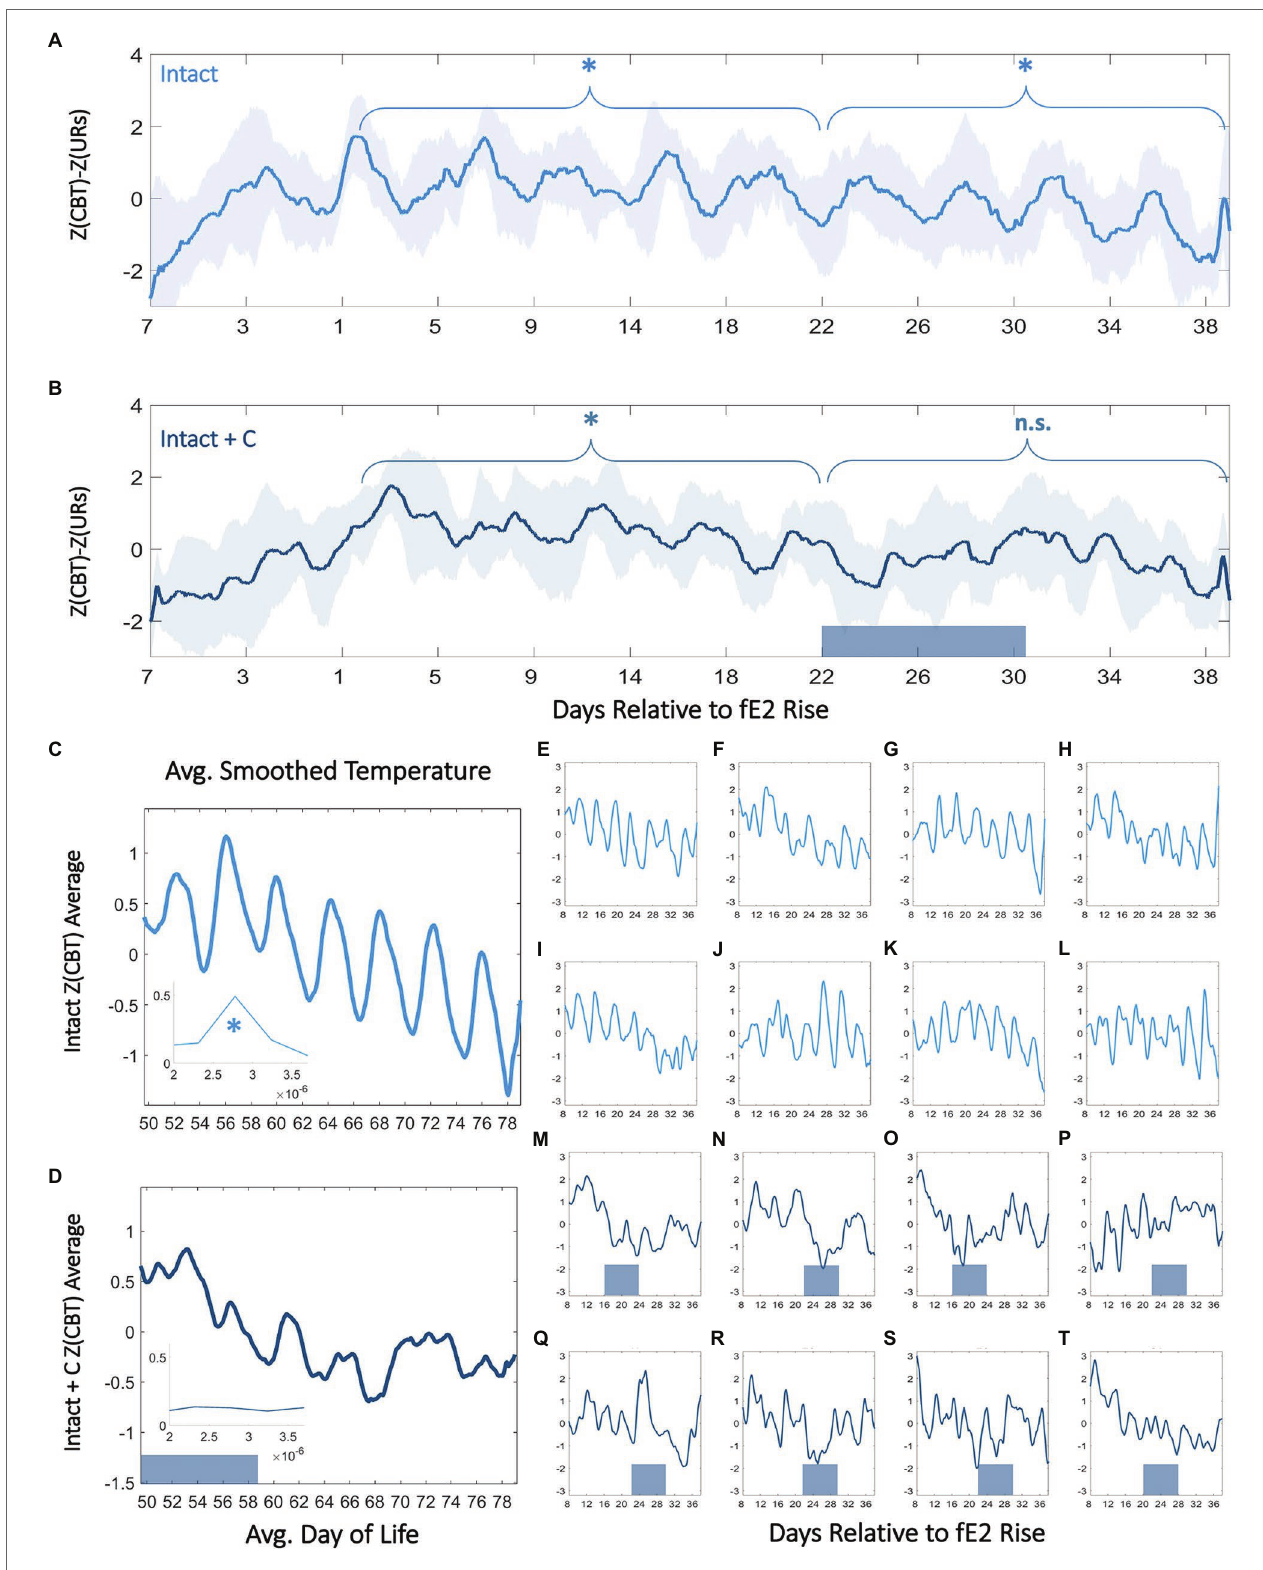
FIGURE 3 | Contraceptive administration in adolescence persistently perturbs 4-day temperature rhythms. Normalized CBT mean (±SD) minus ultradian rhythm (UR) power relative to within-individual first day of fE2 rise in Intact (A) and Intact + C (B) rats (see: Materials and Methods and Supplementary Figure 3 ). Dark